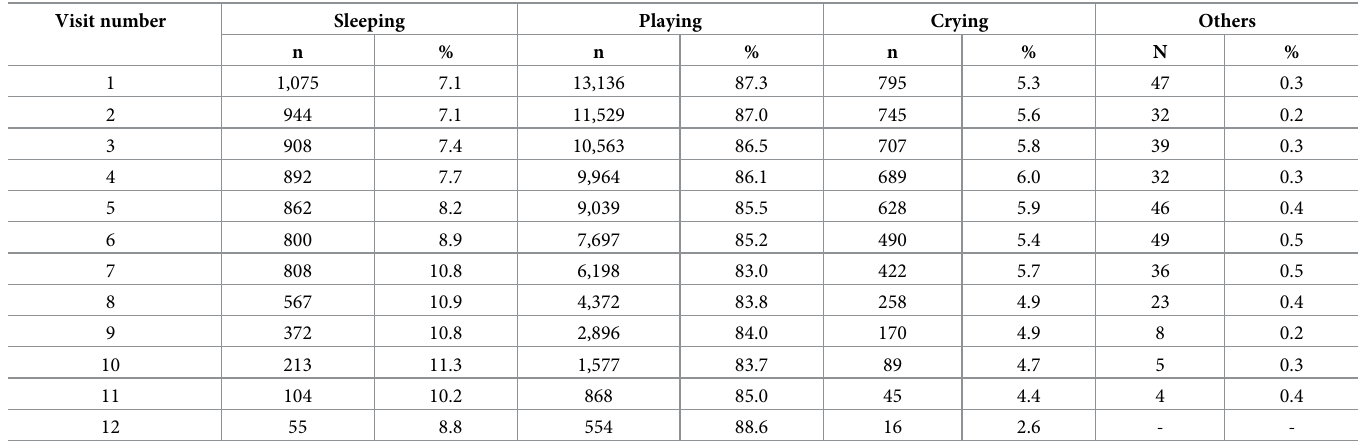
Table 3. Child activities during playpen compliance